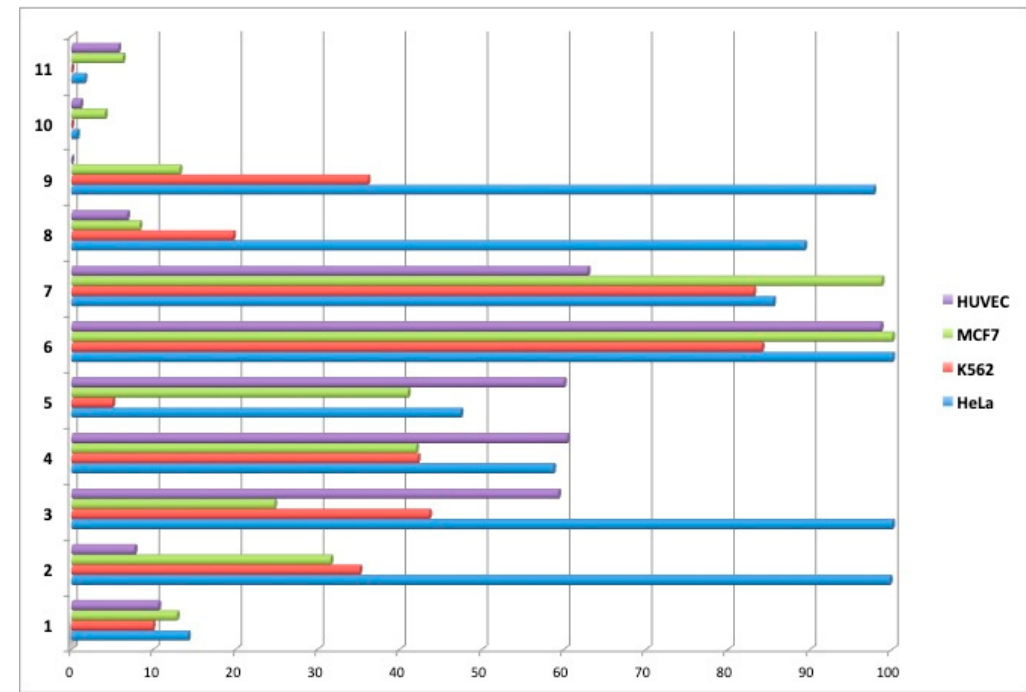
Figure 3. Cell survival [%] after 48 h incubation with test compounds at 100 µM. Table 1. The IC 50 values calculated from the dose-response curves. Cells were incubated with compounds for 48 h. All the values are given in µ M. Compound HeLa K562